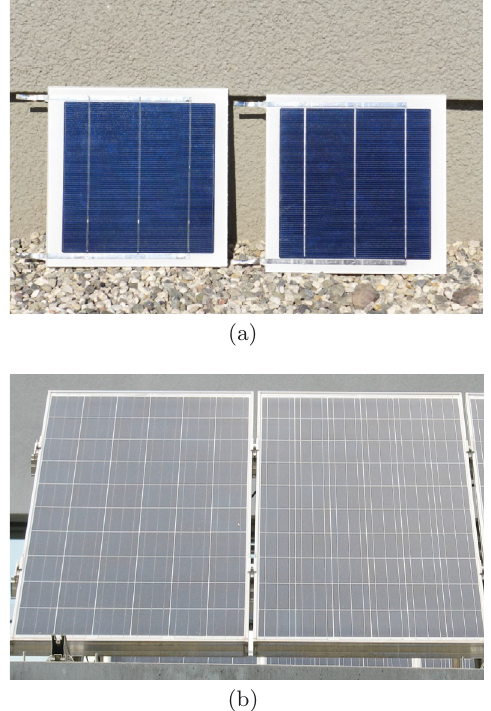
Fig. 3. (a) Photograph of an irradiated mini module with LCR ribbons (left) in comparison to a standard flat ribbon mini module (right). (b) Photograph of an irradiated module with LCR ribbons (left) in comparison to a standard flat ribbon module